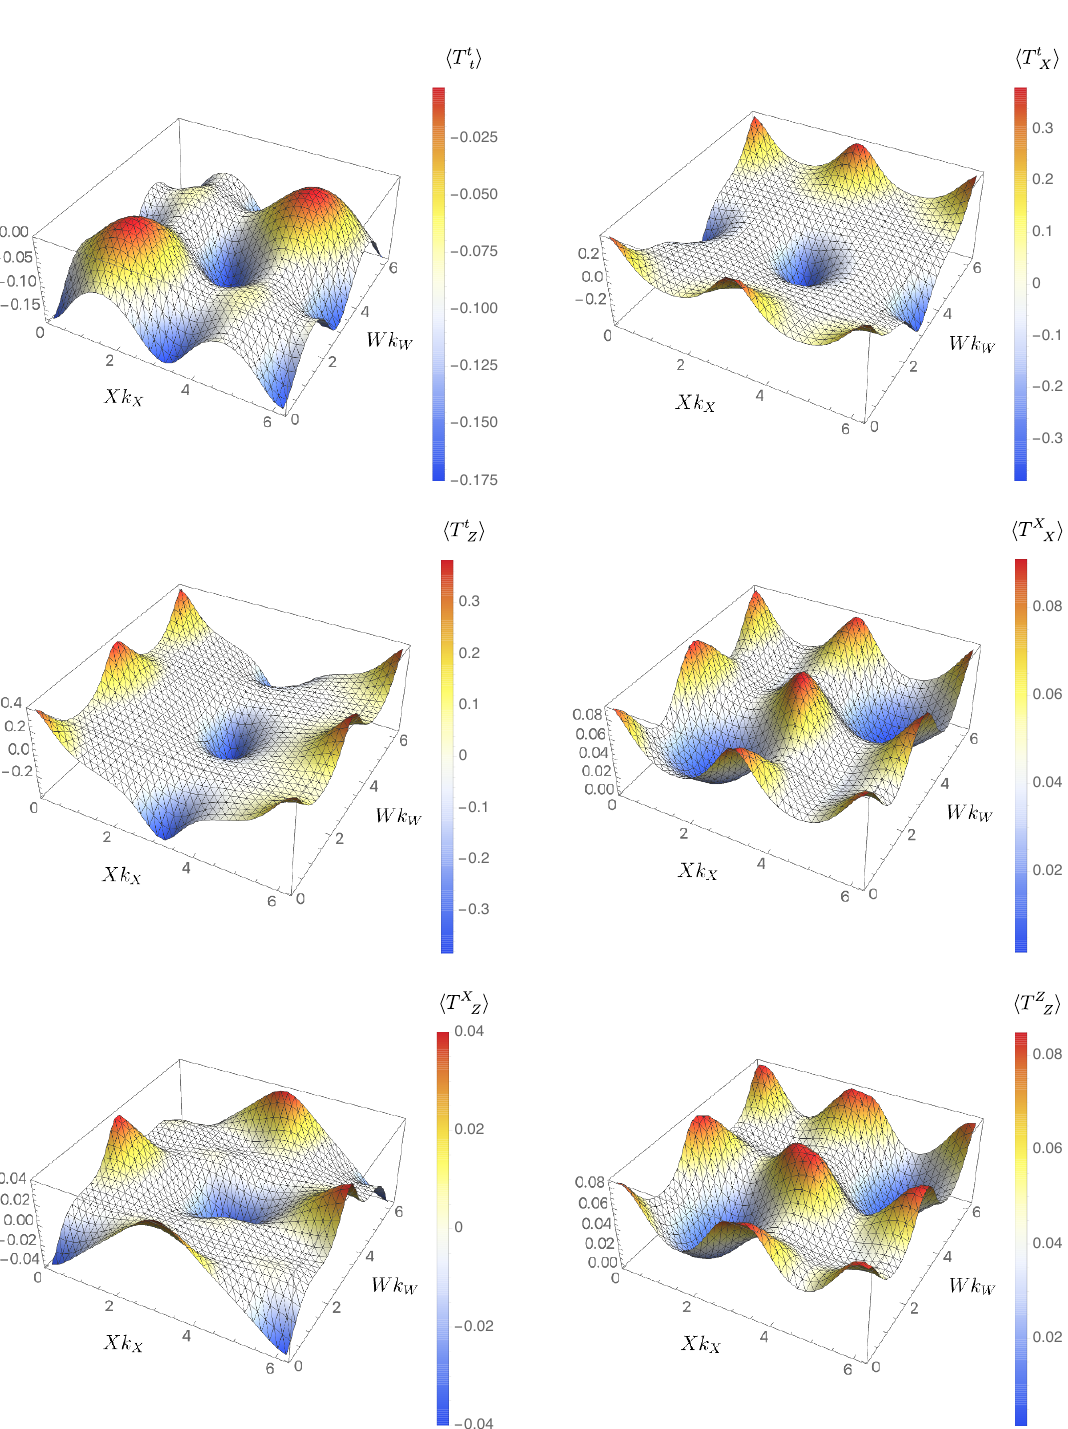
Figure 25 . All the components of the holographic stress energy tensor h T (cid:22) about both circles. These plots are for T=k W = 0 : 239, k X = k W , and a = 0 : 6.